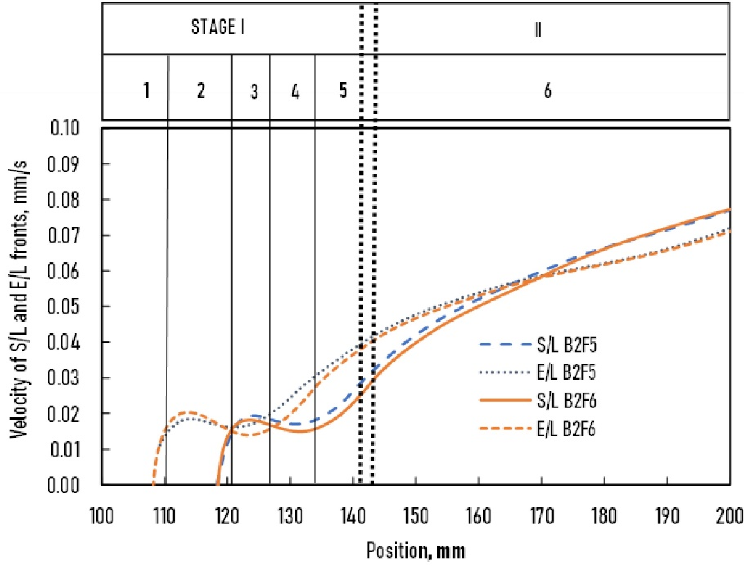
Figure 4. Velocity of S/L and E/L fronts vs. position of B2F5 and B2F6 samples. The curves of the S/L and E/L fronts for samples B2F1 and B2F2 were nearly the same